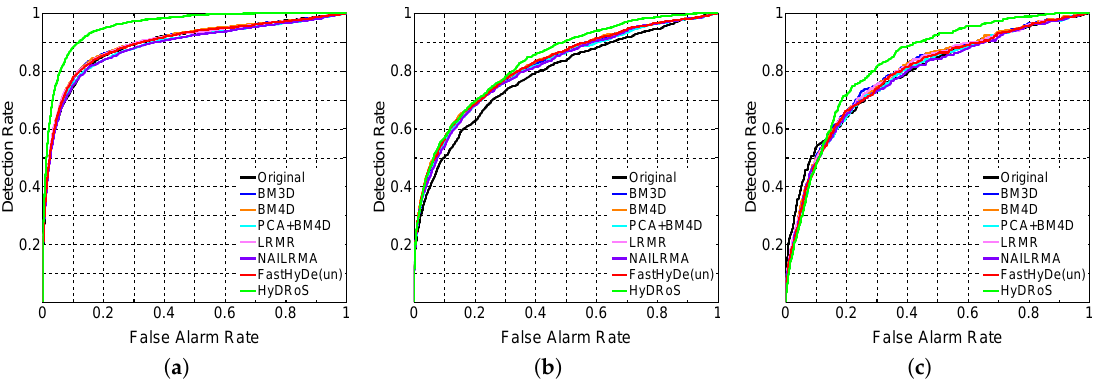
Figure 13. ROC curves for the three minerals obtained by SAM: ( a ) Alunite; ( b ) Chalcedony; ( c ) Kaolinite.